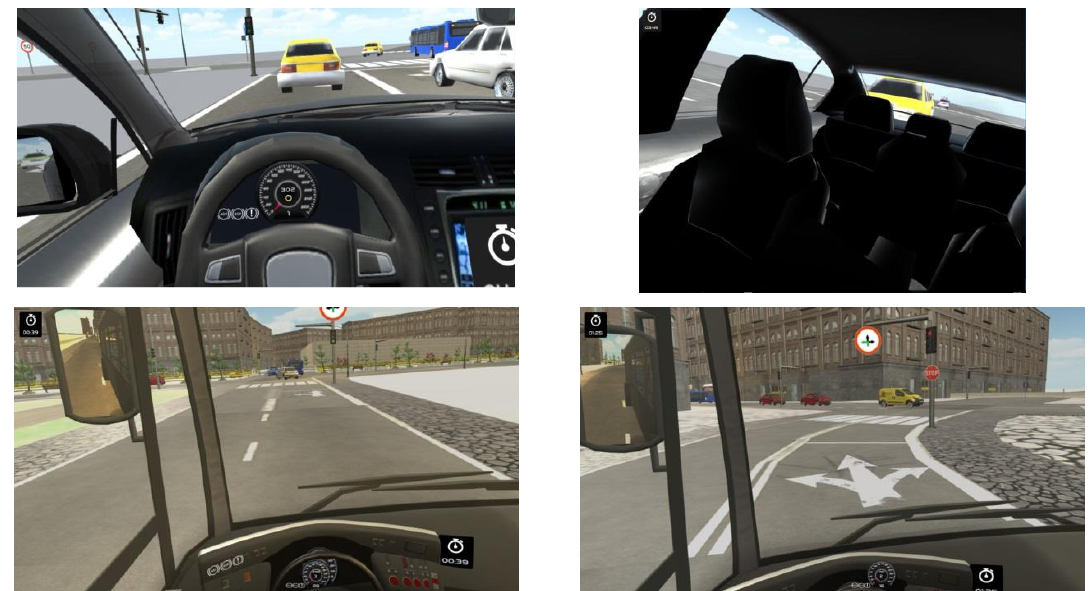
Figure 4. Images watched using Oculus Rift as the visualization display in the simulator.